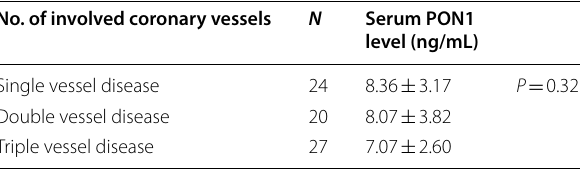
Table 7 PON1 levels of CAD patients and the number of involved coronary